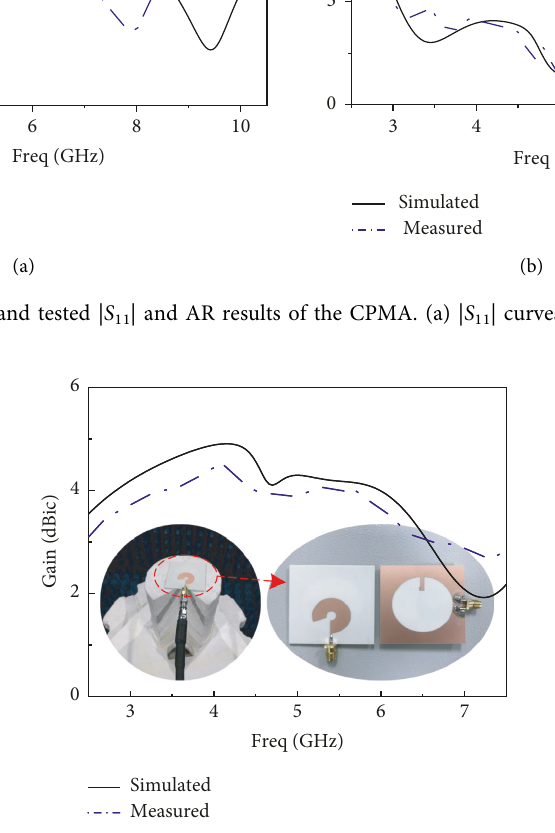
Figure 7: Simulated and tested gain curves and measurement photos of the CPMA.